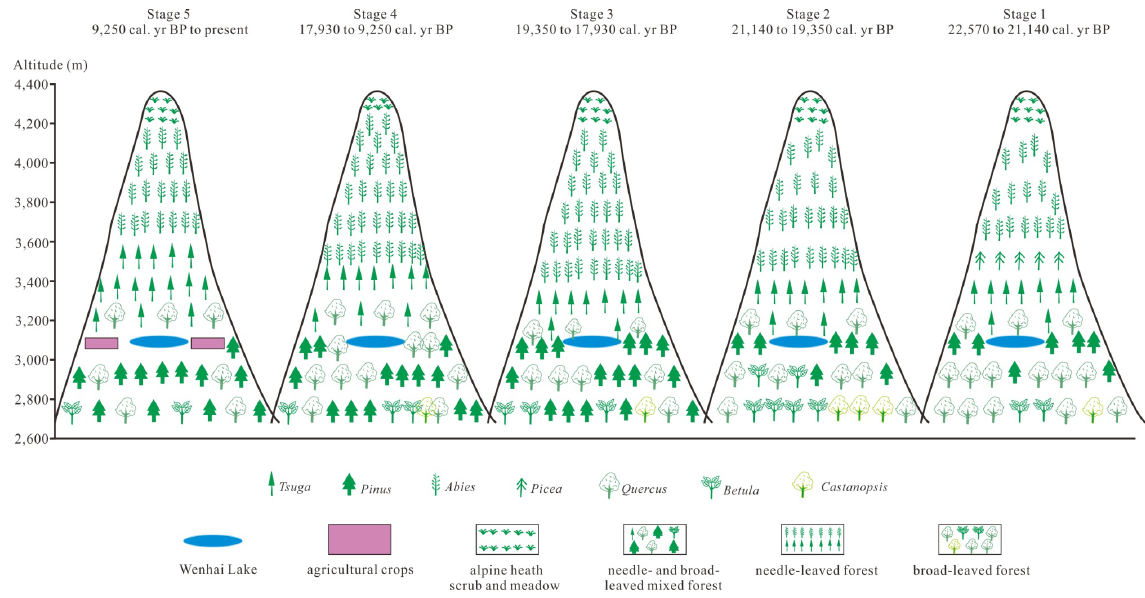
Figure 3. Schematic diagrams showing vegetation succession over the past 22570 years at